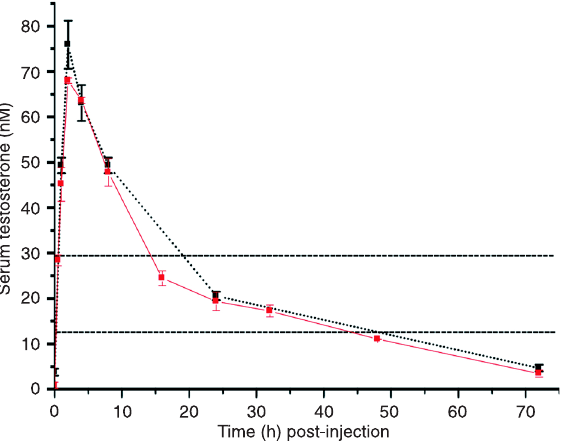
Figure 1. Pharmacokinetic curves of the single and double 72-h period injection of testosterone propionate in castrated littermates.